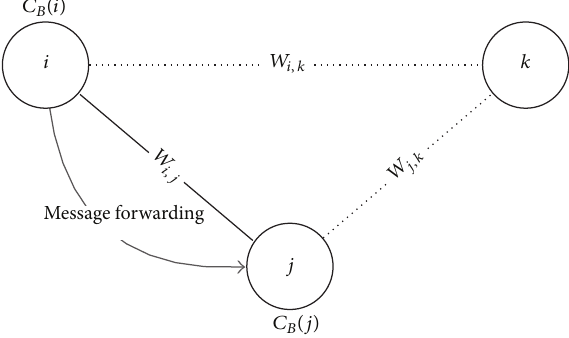
Figure 2: Message forwarding condition: 𝑤 𝑗,𝑘 > 𝑤 𝑖,𝑘 or 𝐶 𝐵 (𝑗) > (𝑖) 𝐶 𝐵